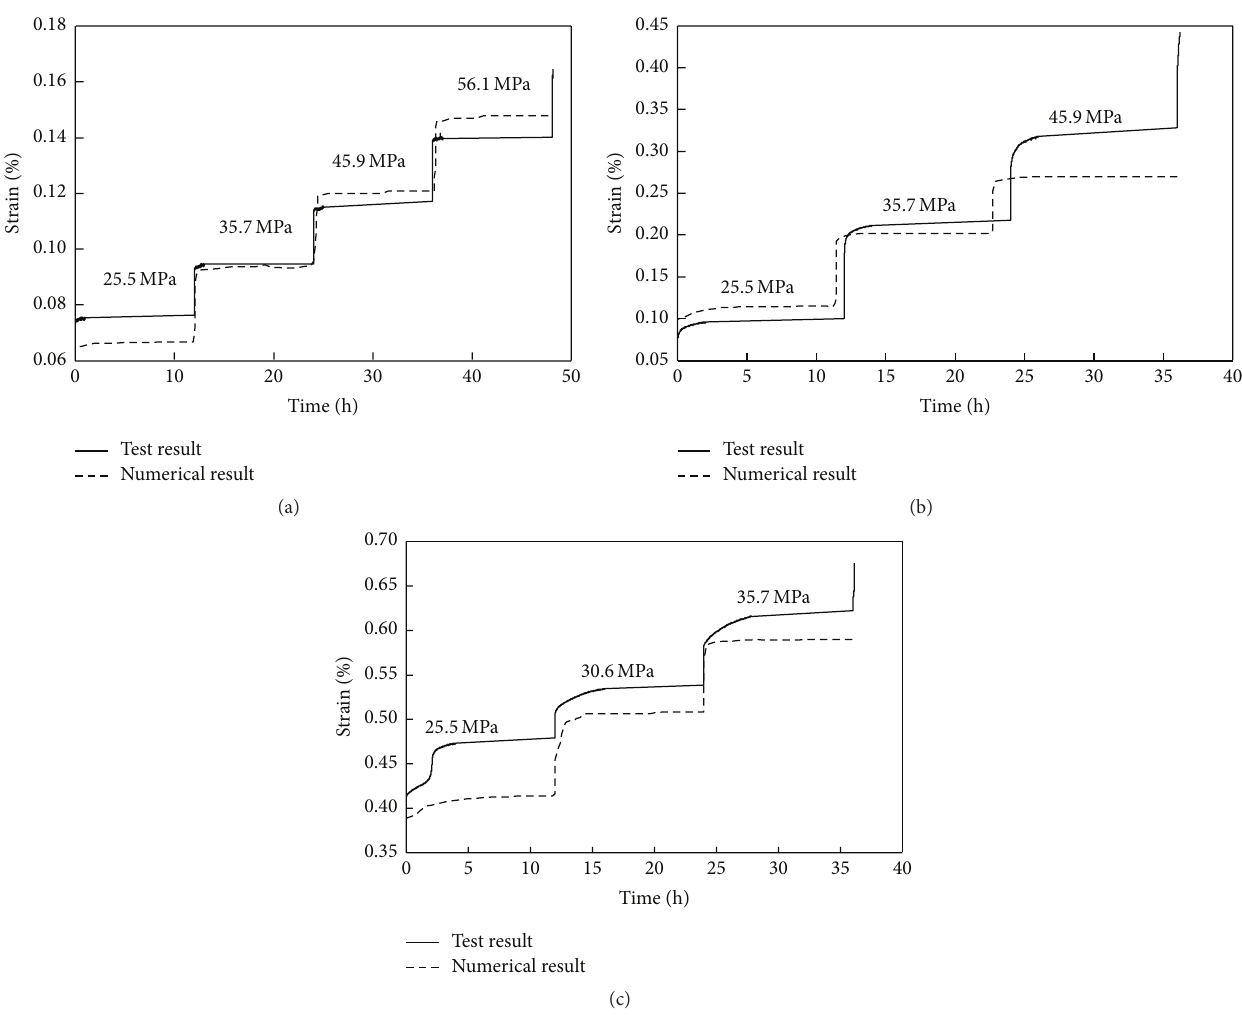
Figure 8: Comparison between numerical data and laboratory test data of specimens with different saturation degrees: (a) 𝑆 = 41.5 %; (b) 𝑆 = 80.1 %; (c) 𝑆 = 93.5 %.